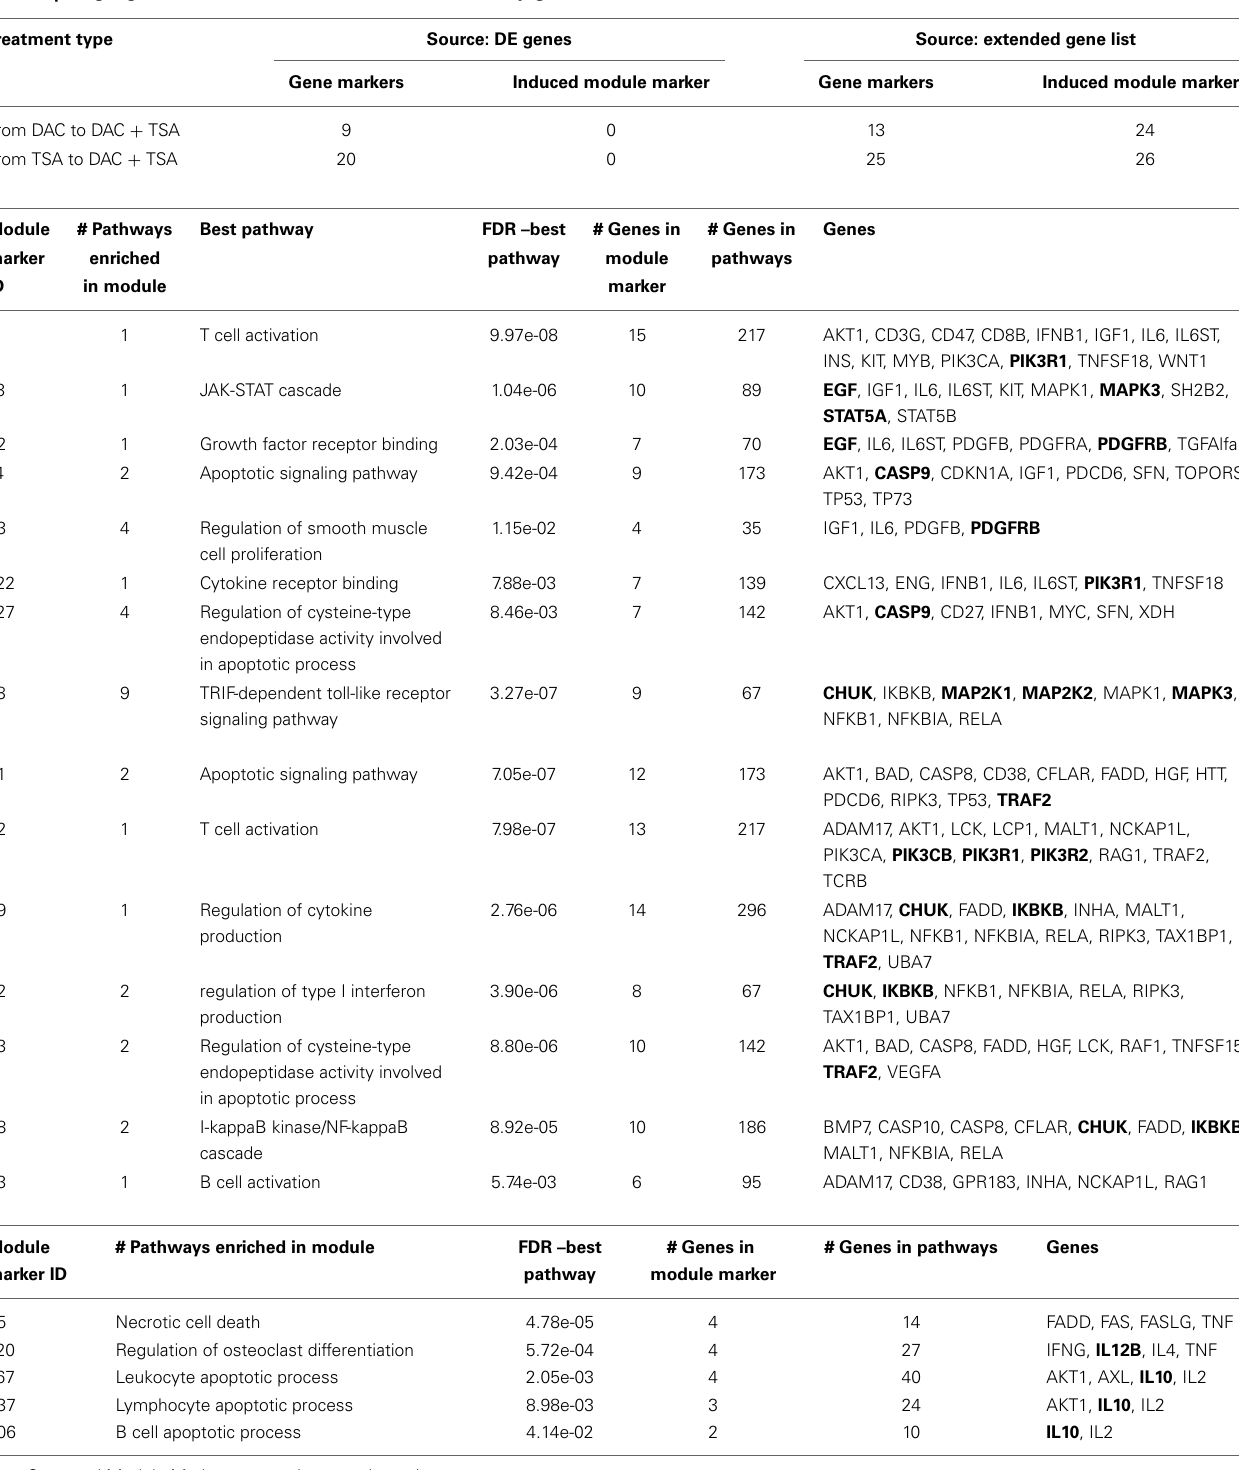
Table 1 | Single gene marker versus module marker across epigenetic treatments.